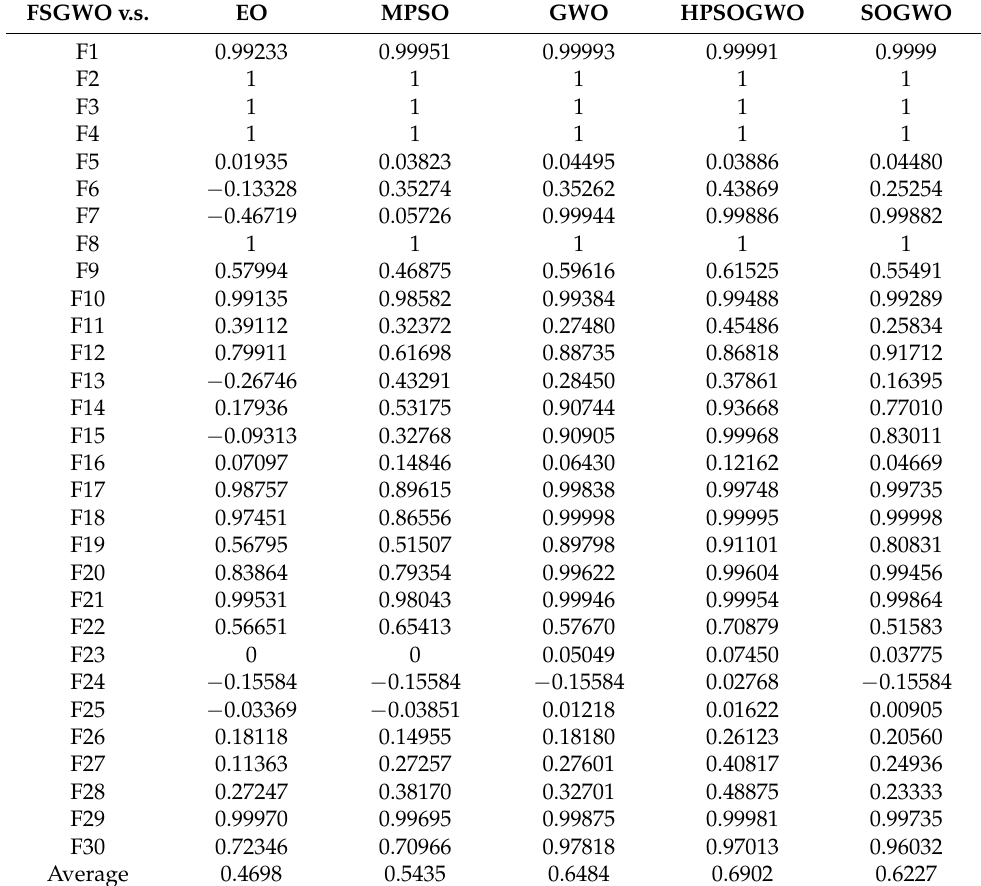
Table 4. Comparison of the calculation accuracy of related algorithms for 30 30D test functions. FSGWO